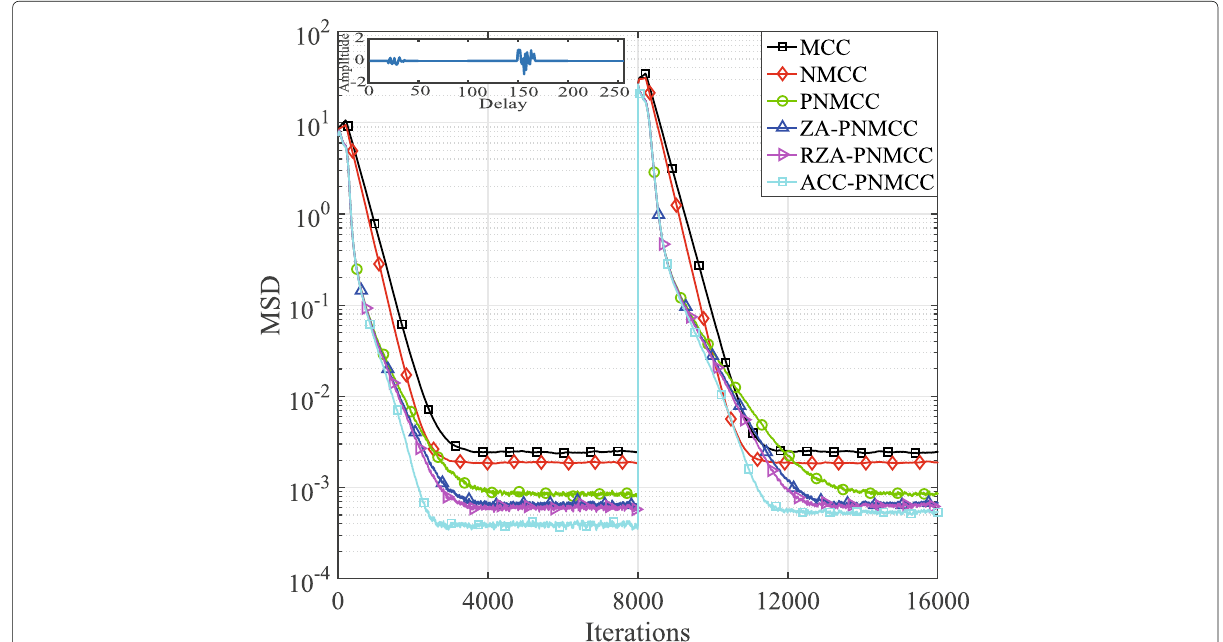
Fig. 9 The MSD performance of the proposed ACC-PNMCC algorithm in echo cancelation